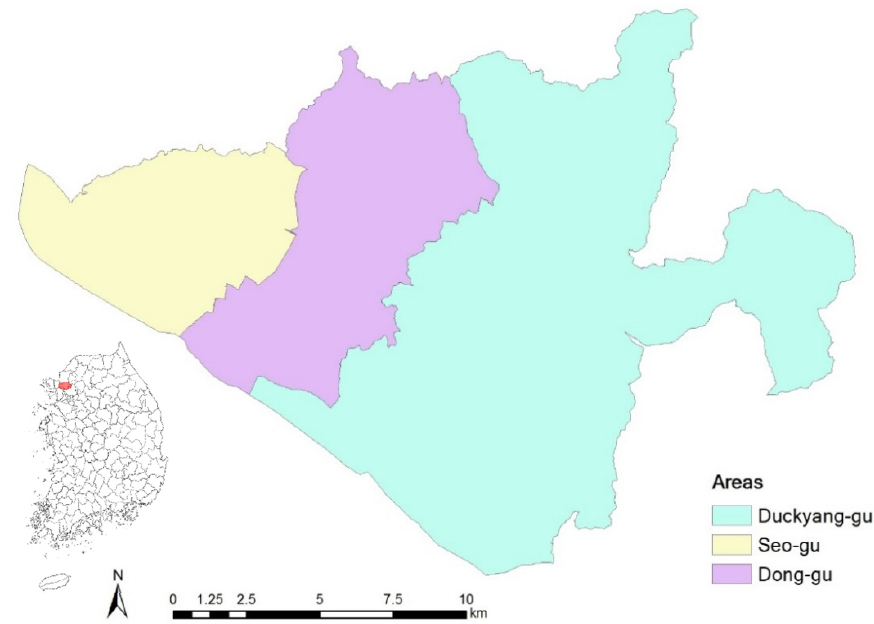
Figure 2. Location of three areas in Goyang city: Seo-gu, Dong-gu, and Deokyang-gu.